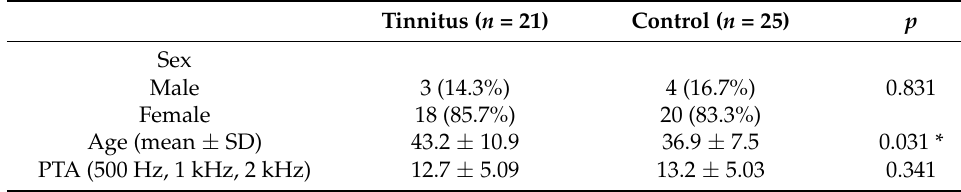
Table 1. Characteristics of participants in the tinnitus and control groups.